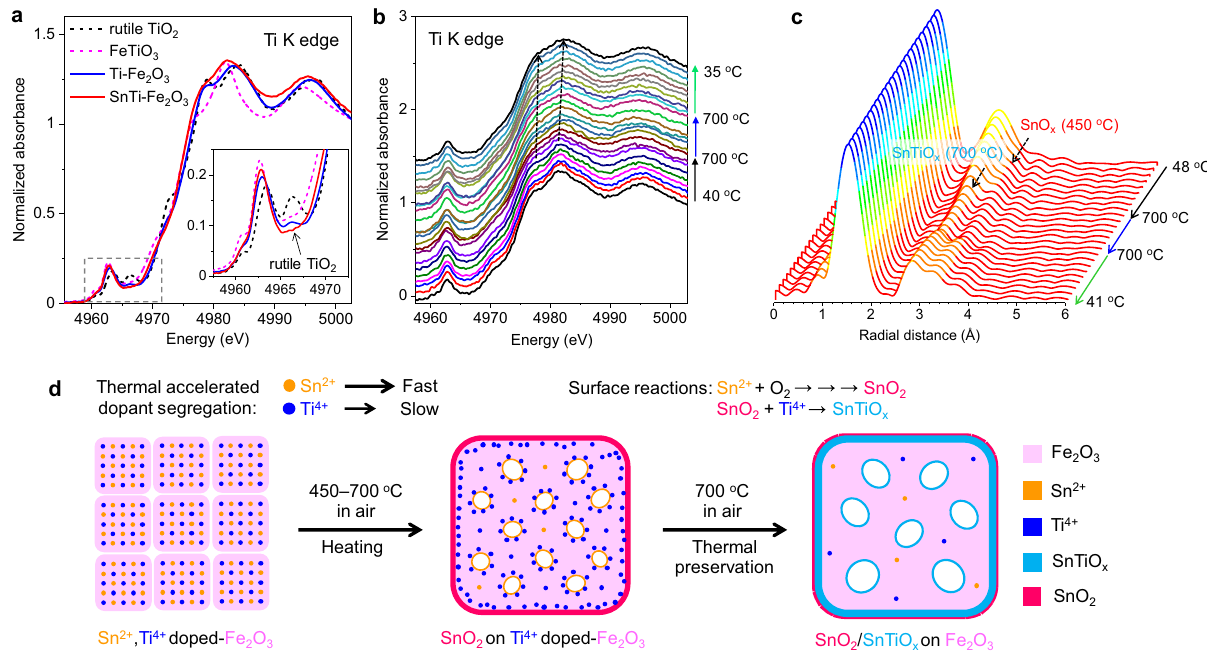
Fig. 4 In situ observation of dopant segregation. a Ex situ Ti K-edge XANES spectra of annealed Ti-containing samples and reference samples. b In situ Ti K-edge XANES spectra of as-synthesized SnTi – Fe 2 O 3 measured with the similar heating procedure used for electrodes preparation. The spectra are shifted along the y- axis for the sake of better clarity. c In situ FT-EXAFS spectra of as-synthesized SnTi – Fe 2 O 3 measured with the similar heating procedure used for electrodes preparation. d Schematic illustration of the binary dopant segregation enabling the heterostructures during thermal treatment of as- synthesized SnTi – Fe 2 O 3